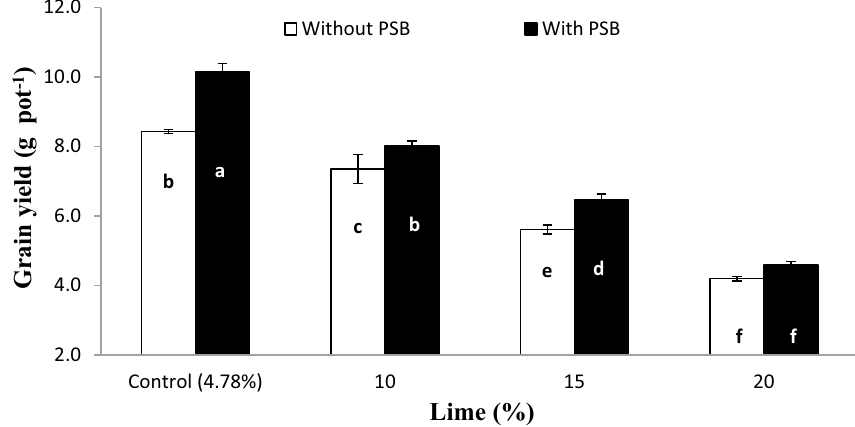
Figure 6. Interactive effect of lime and PSB on grain yield (g pot −1 ). Graph bars having different letters are significantly different at α = 0.05. Errors bar represent standard error for the mean of three values.